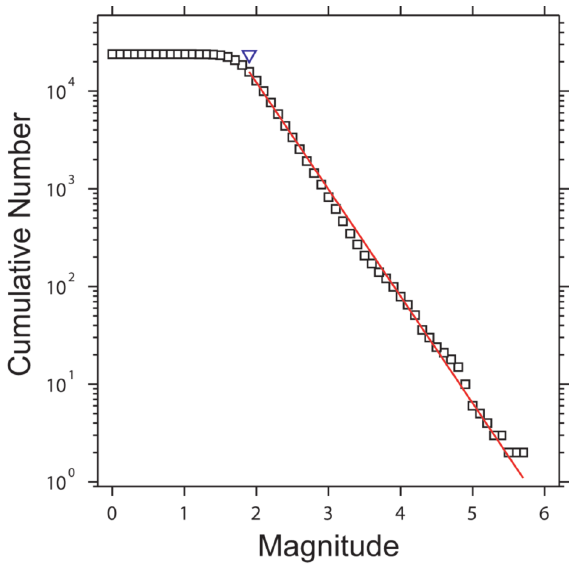
Figure 3. Cumulative number of earthquakes as a function of m . Based on events in the period from April 16, 2005, to March 31, 2009. The straight line shows the GR law in Equation (1), with b = 1.19 and A = 6.28. The inverted = triangle indicates M C